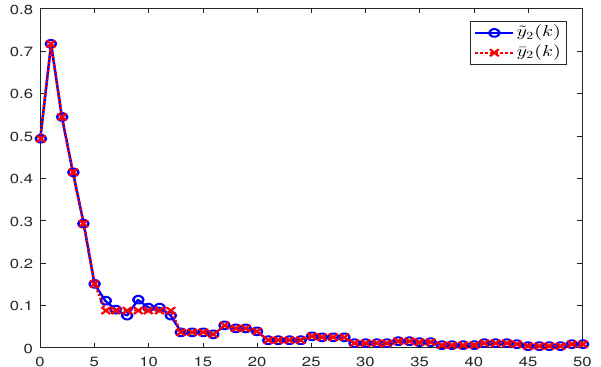
Figure 2. Event-triggered output signal ˜ y 1 ( k ) and quantified output signal ¯ y 1 ( k ) .